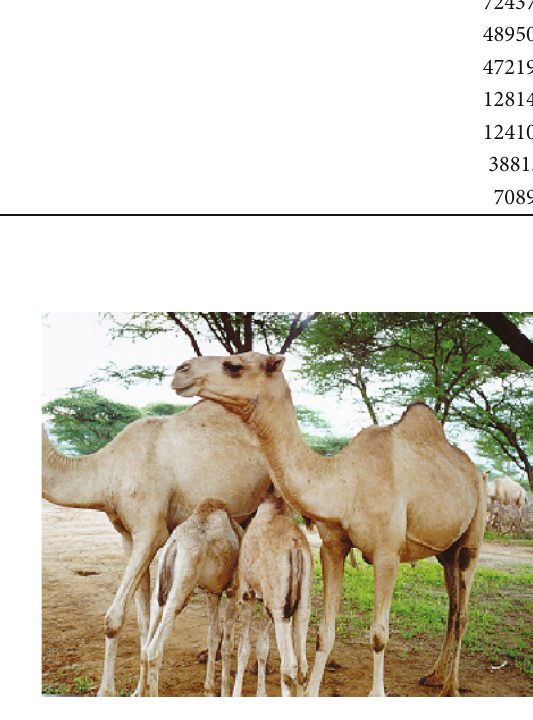
Figure 2: The Gabbra/Rendile breeds. Source: [17] (with permission from authors).